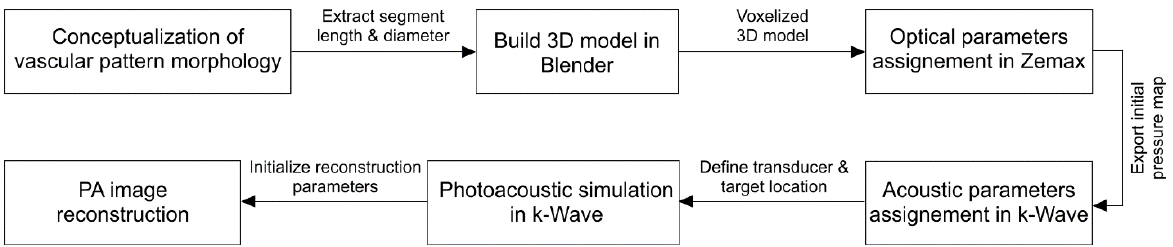
Figure 1. Process steps to develop a 3D vasculature digital phantom and test it in a photoacoustic simulation.